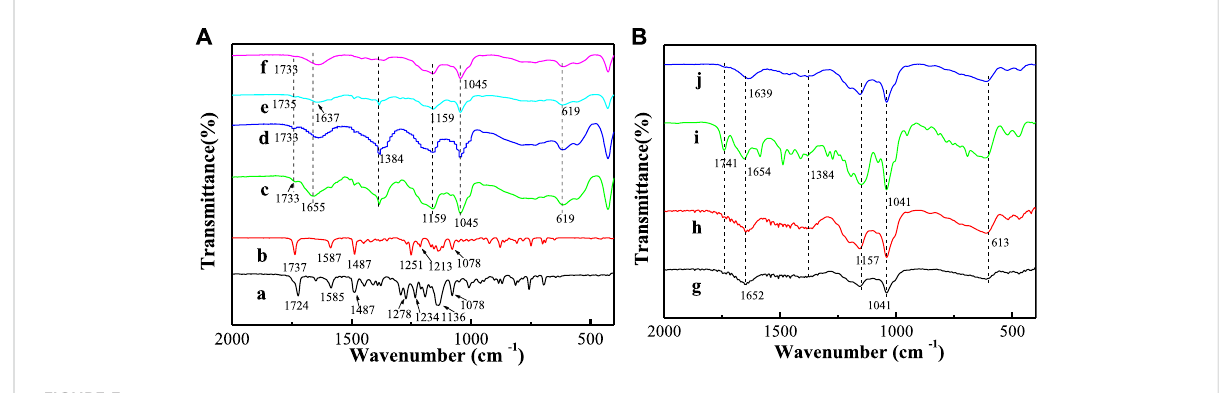
FIGURE 3 FT-IR spectra ofsamples (a) LCT; (b) BCT; (c) BCT/SBECD-LDH (N); (d) BCT/SBECD-LDH (E); (e) LCT/SBECD-LDH (N); (f) LCT/SBECD-LDH (E); (g) BCT/SBECD-LHS (N); (h) BCT/SBECD-LHS (E); (i) LCT/SBECD-LHS (N); (j) LCT/SBECD-LHS